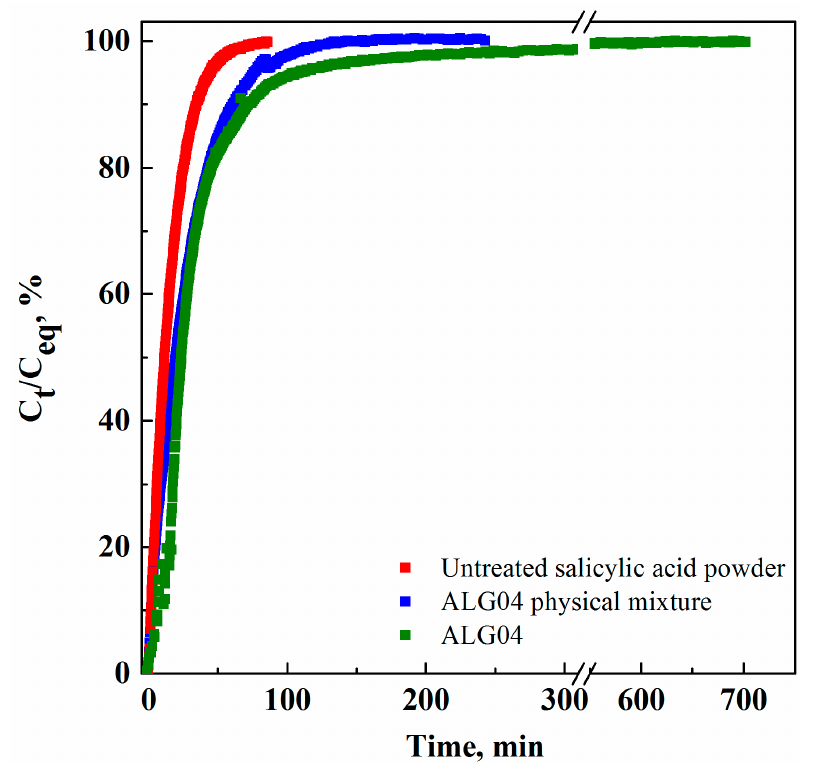
Figure 7. Salicylic acid release profiles from sodium alginate microparticles produced via SAA at 80 °C, 82 bar, and GLR =